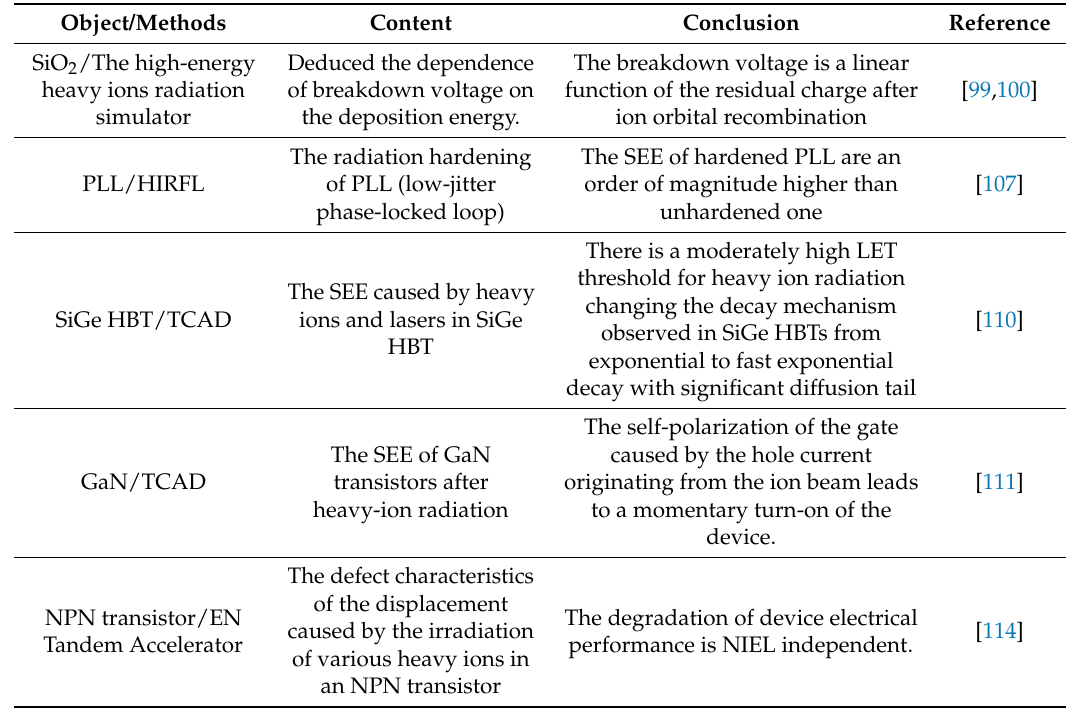
Table 7. The impact of high-energy heavy ions on semiconductor device research.